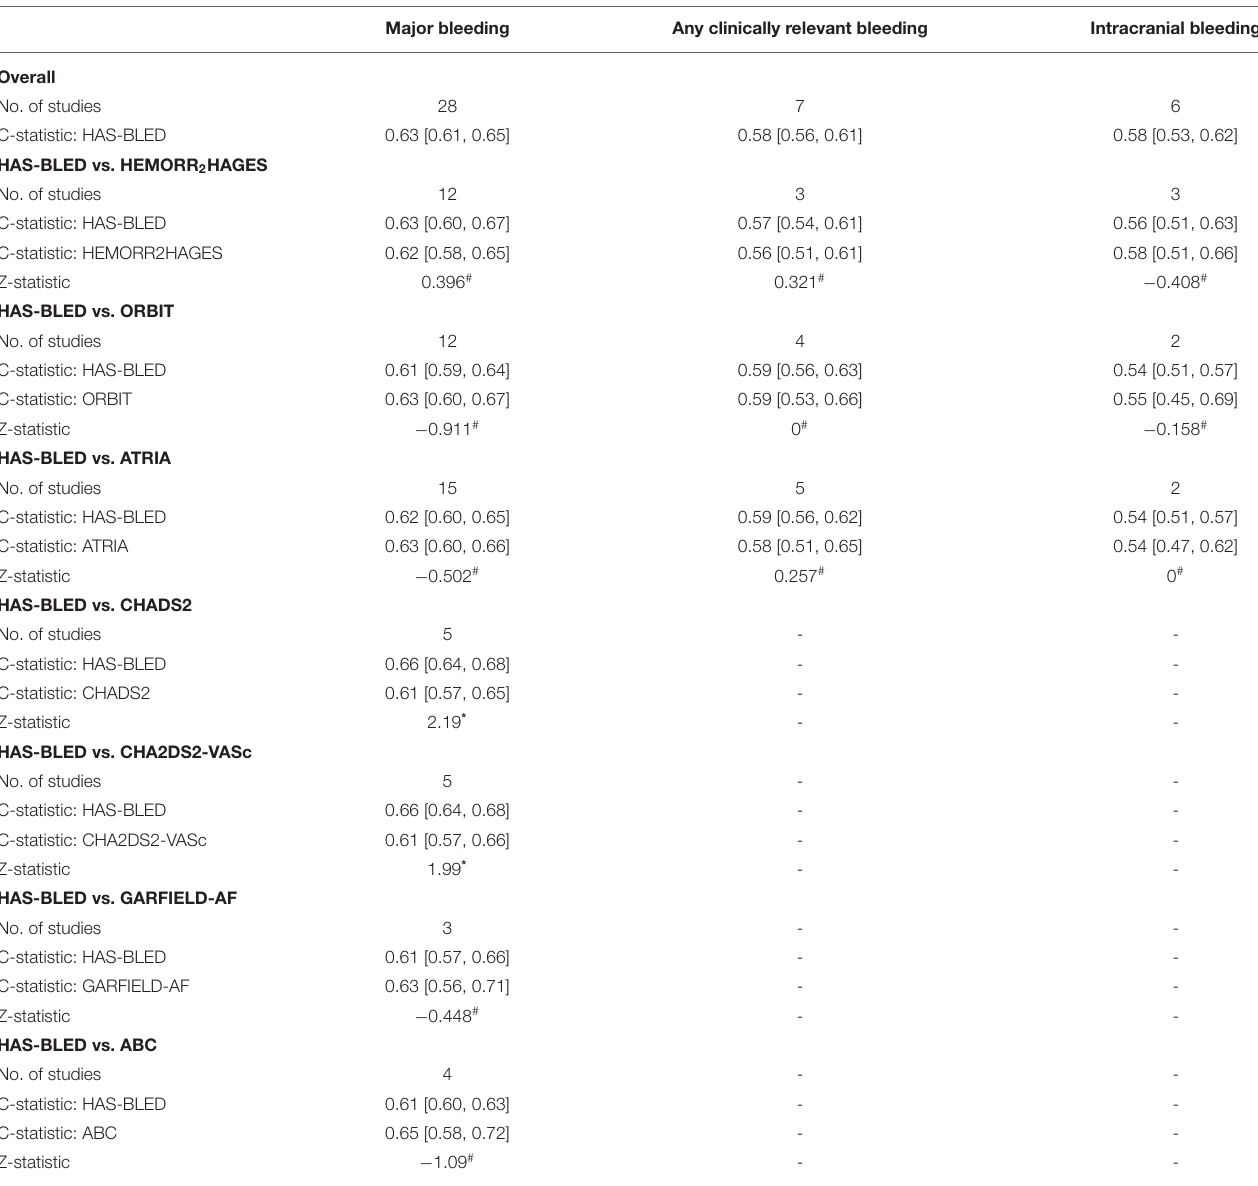
TABLE 2 | Summary of the C-statistic and 95% CIs of the included studies. Major bleeding Any clinically relevant bleeding Intracranial